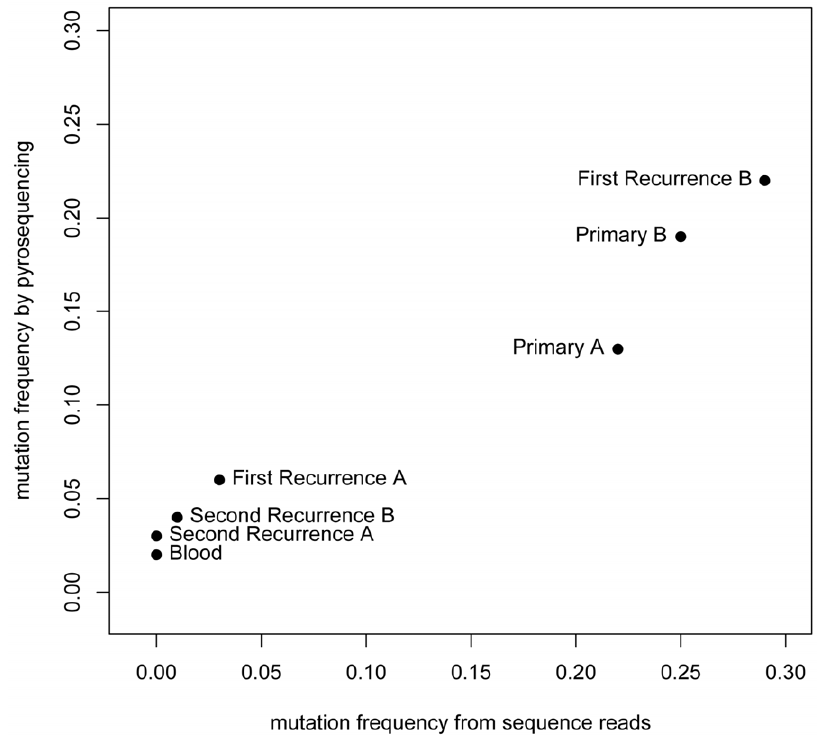
Figure 3. Validation of PTEN mutation. For the sequencing data, the percentage of reads harboring the mutation (horizontal axis) is used as an estimate of the mutation frequency in each sample, plotted against the pyrosequencing frequency estimates (vertical axis; see Materials and Methods). doi:10.1371/journal.pone.0035262.g003 PLoS ONE |